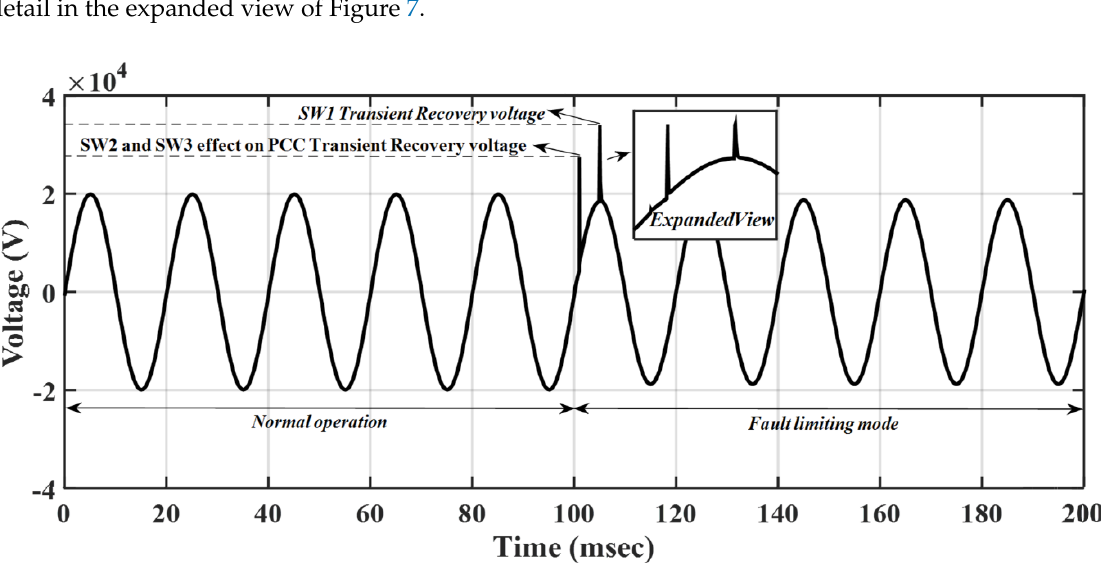
Figure 7. The effect of SW 2 and SW 3 on the PCC transient recovery voltage and the SW 1 transient recovery voltage.